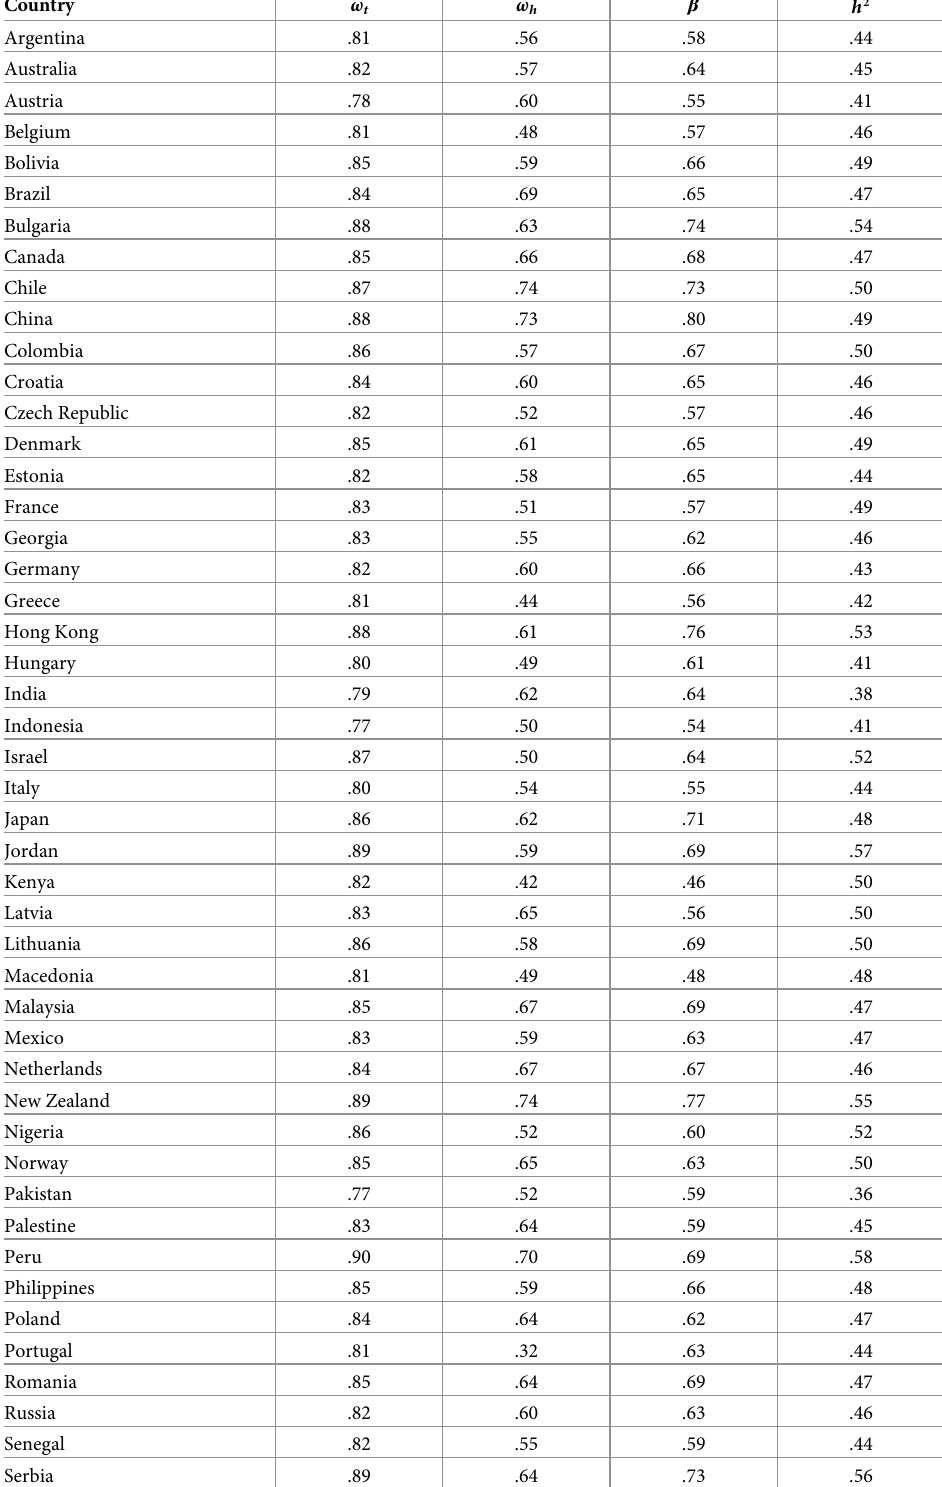
Table 3. Reliability measures of the Interdependent Happiness Scale (IHS) by